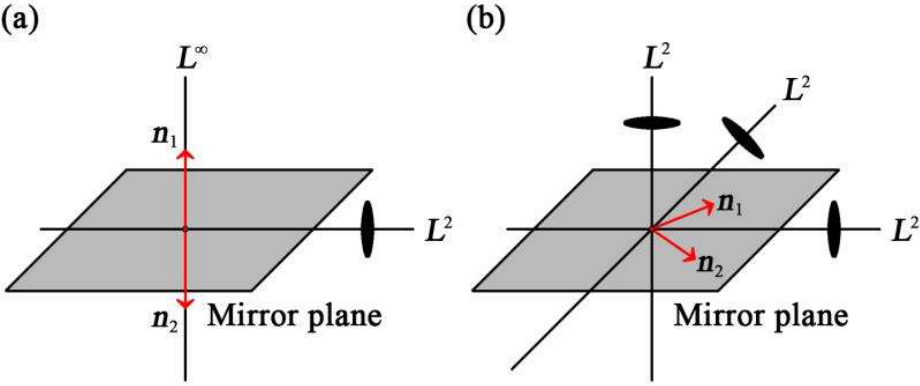
Figure 2. The two unit vectors and the corresponding symmetry elements: ( a ) D ∞ h symmetry, its elements are made up of L ∞ ∞ L 2 ( ∞ + 1 ) PC ; ( b ) D 2 h symmetry, its elements are made up of 3 L 2 3 PC .